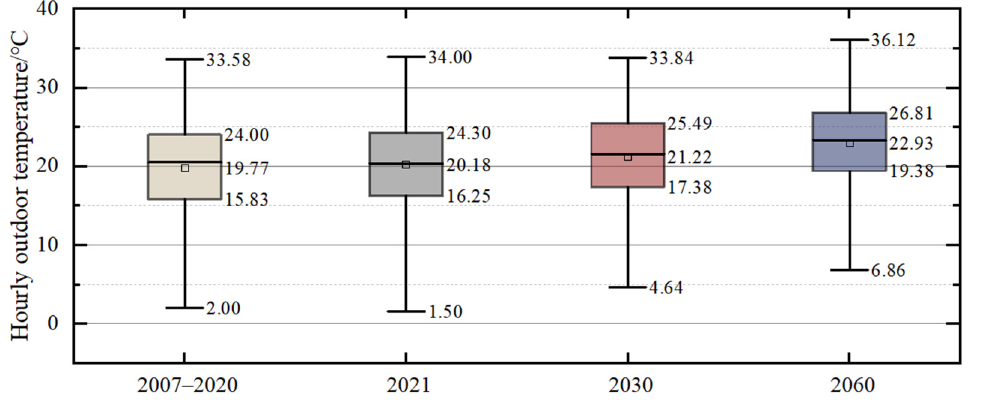
Figure 5. Outdoor temperature in different periods in Changchun.